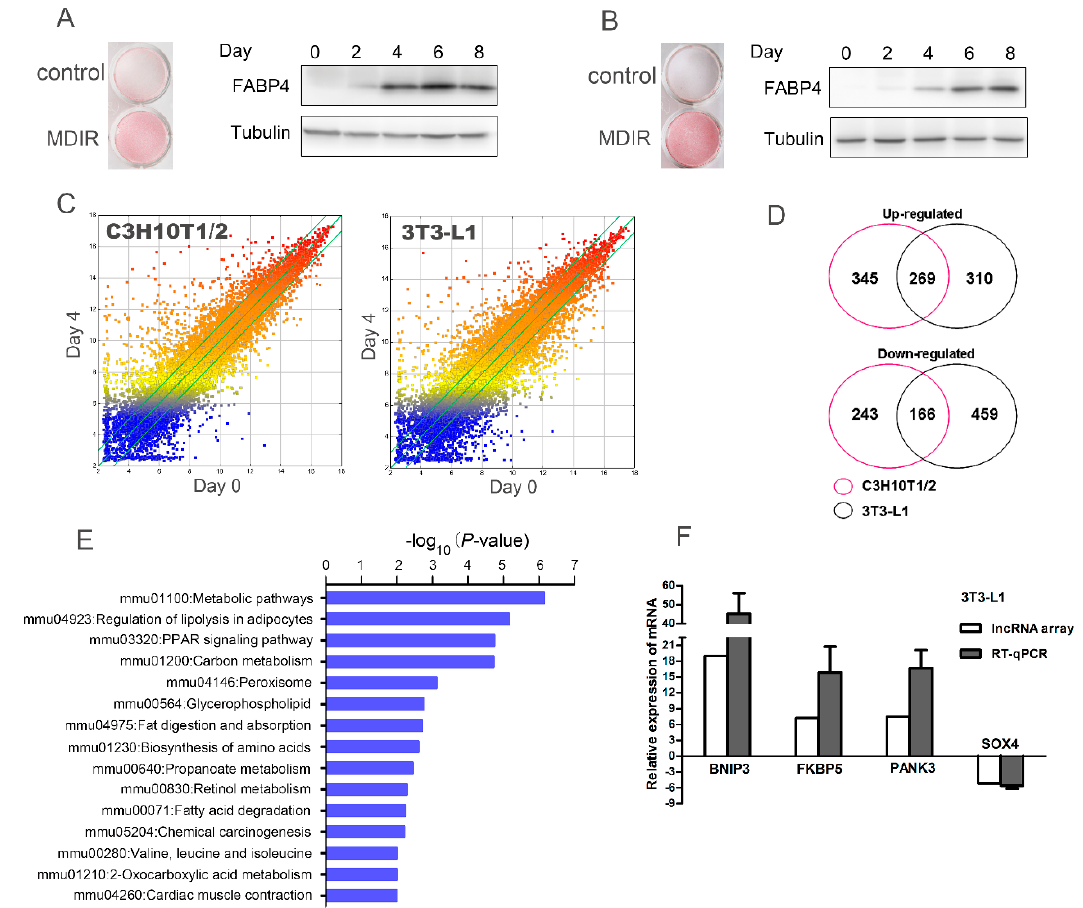
Figure 1. The differentially expressed genes in C3H10T1/2 and 3T3-L1 cells undergoing early adipocyte differentiation were identified. The Oil Red O staining and the protein expression of adipogenic marker FABP4 were analyzed after exposure of ( A ) C3H10T1/2 and ( B ) 3T3-L1 to differentiation inducers (IBMX, dexamethasone, insulin, and rosiglitazone, also called MDIR) for 8 days. ( C ) A scatterplot analysis was performed for assessing the variation between the samples. ( D ) The Venn diagram showed a list of more pertinent differentially expressed genes at day 0 and day 4 post-induction. ( E ) The Gene Ontology (GO) analysis and pathway analysis for the differentially expressed genes were conducted using DAVID web-based tools. ( F ) The expression tendency analysis of 4 randomly selected genes using lncRNA array and RT-qPCR demonstrated the reliability of the microarray data.